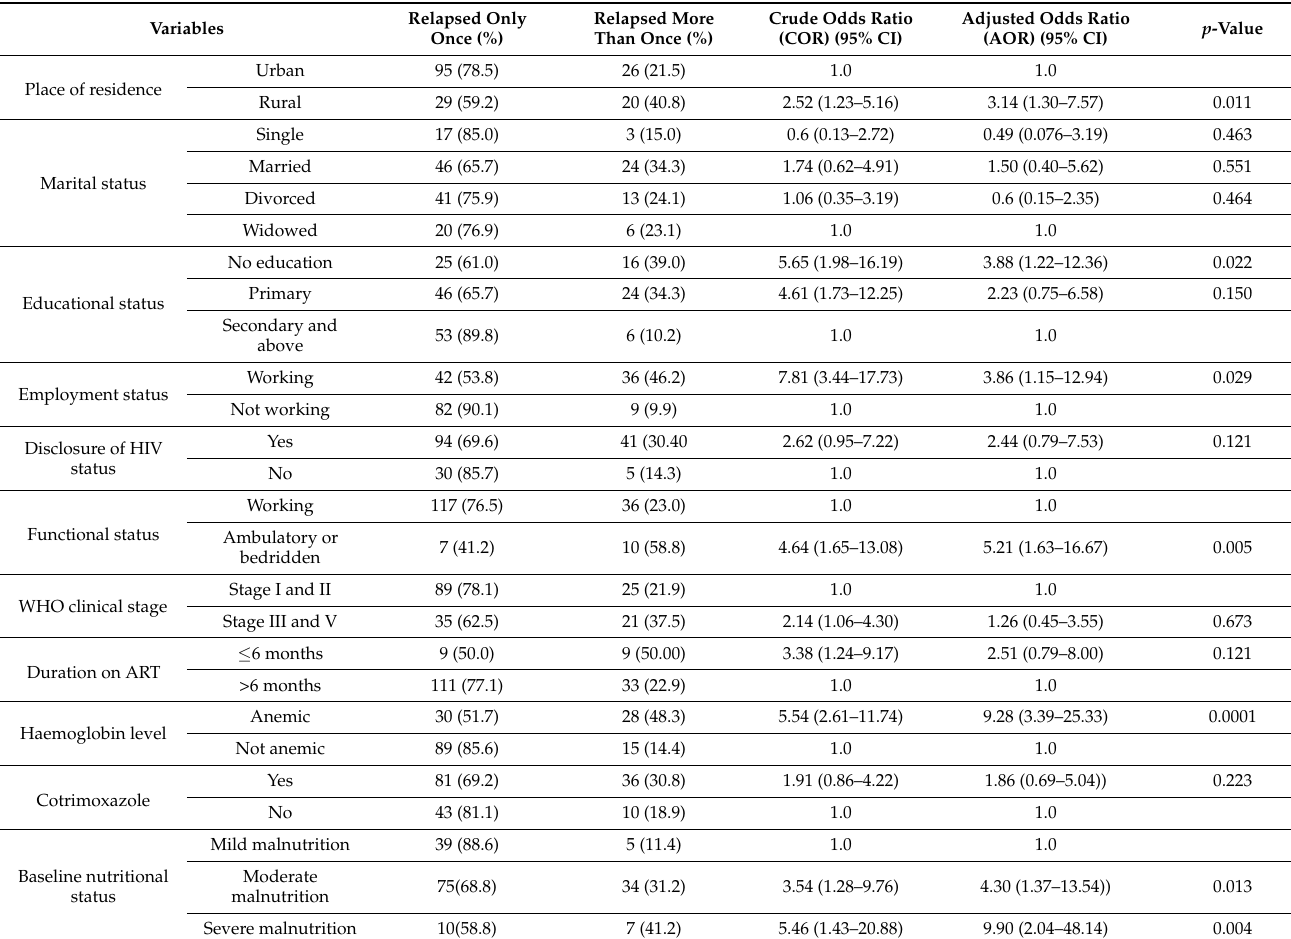
Table 5. Determinants of frequency of relapse into undernutrition after nutritional